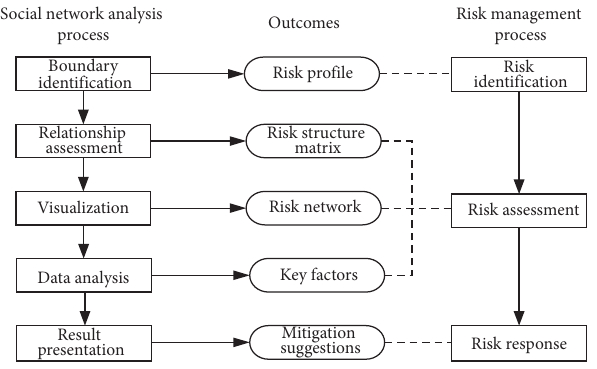
Figure 1: Flowchart of the SNA